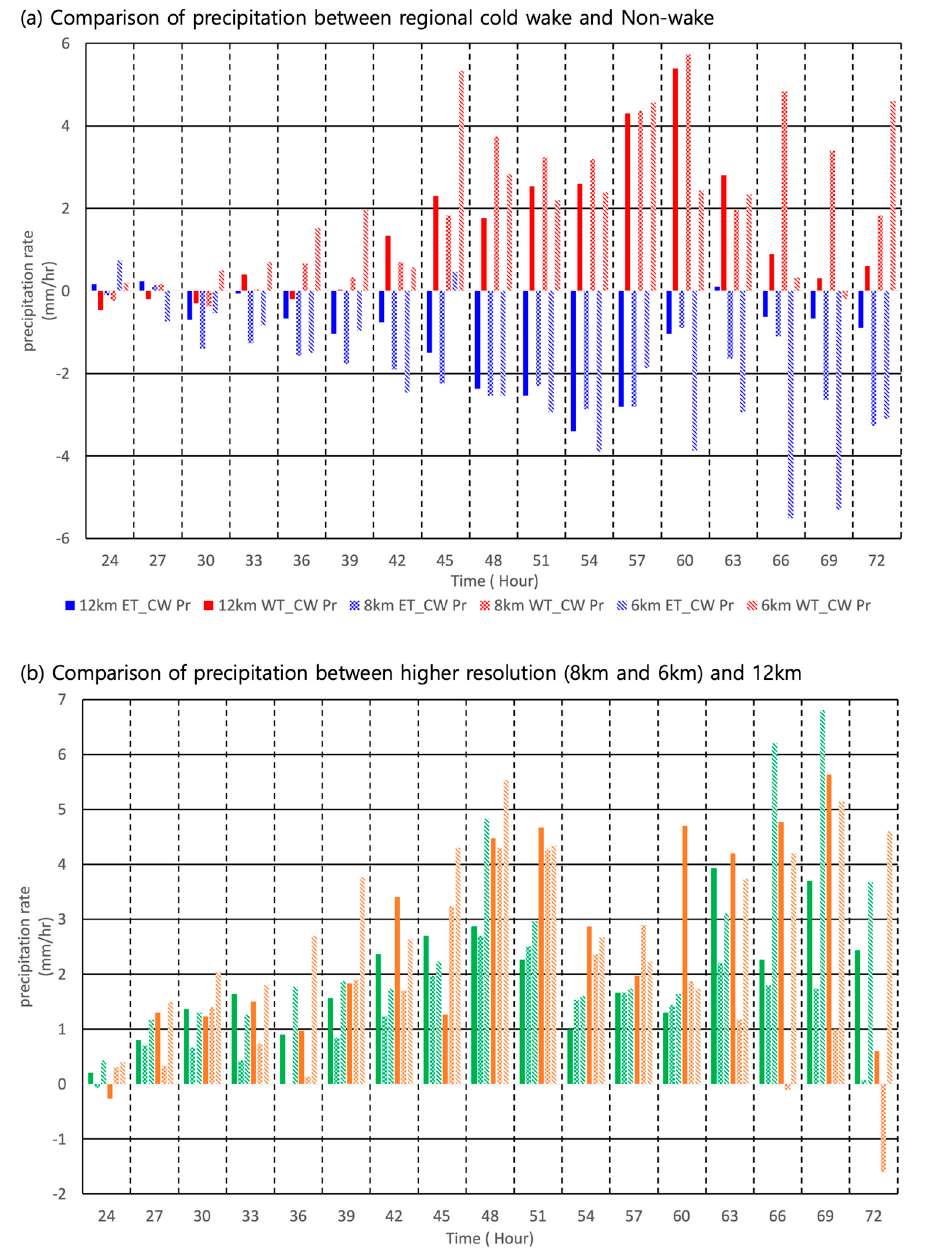
Figure 12. Comparison of area-averaged precipitation rate from the center of TC to 500 km between ( a ) regional cold wake and Non-wake ( b ) higher resolution (8 km and 6 km) and 12 km. Blue (ET_CW) -solid: 12 km, dotted: 8 km, and hatched: 6 km same with red (WT_CW) and green (8 km)—solid: No_CW, dotted: ET_CW, and hatched: WT_CW same with orange (6 km) bar is the difference between each experiment and ( a ) No_CW and ( b ) 12 km.